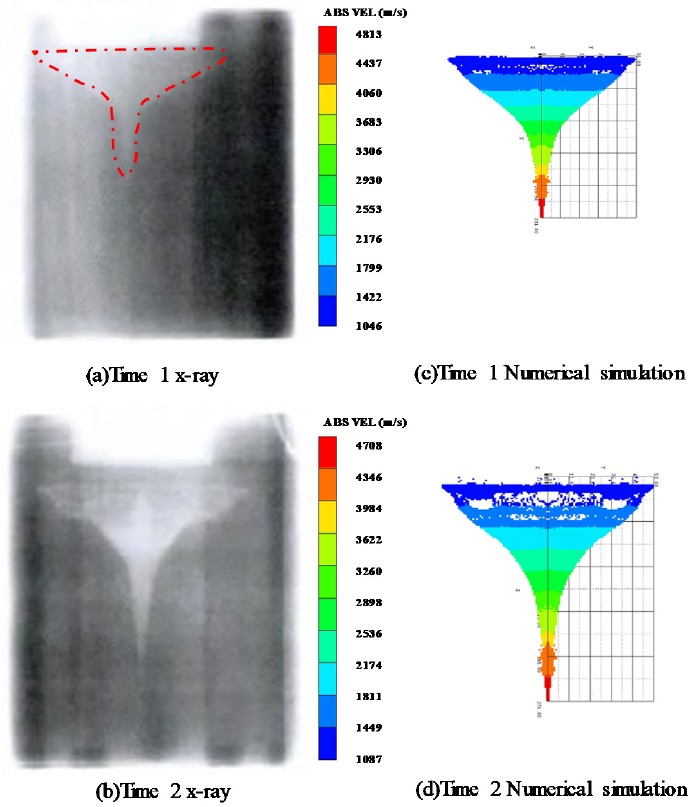
Figure 5. Comparison of experimental results [39] and numerical simulation. Table 5. Simulated EFP head velocity under different grid